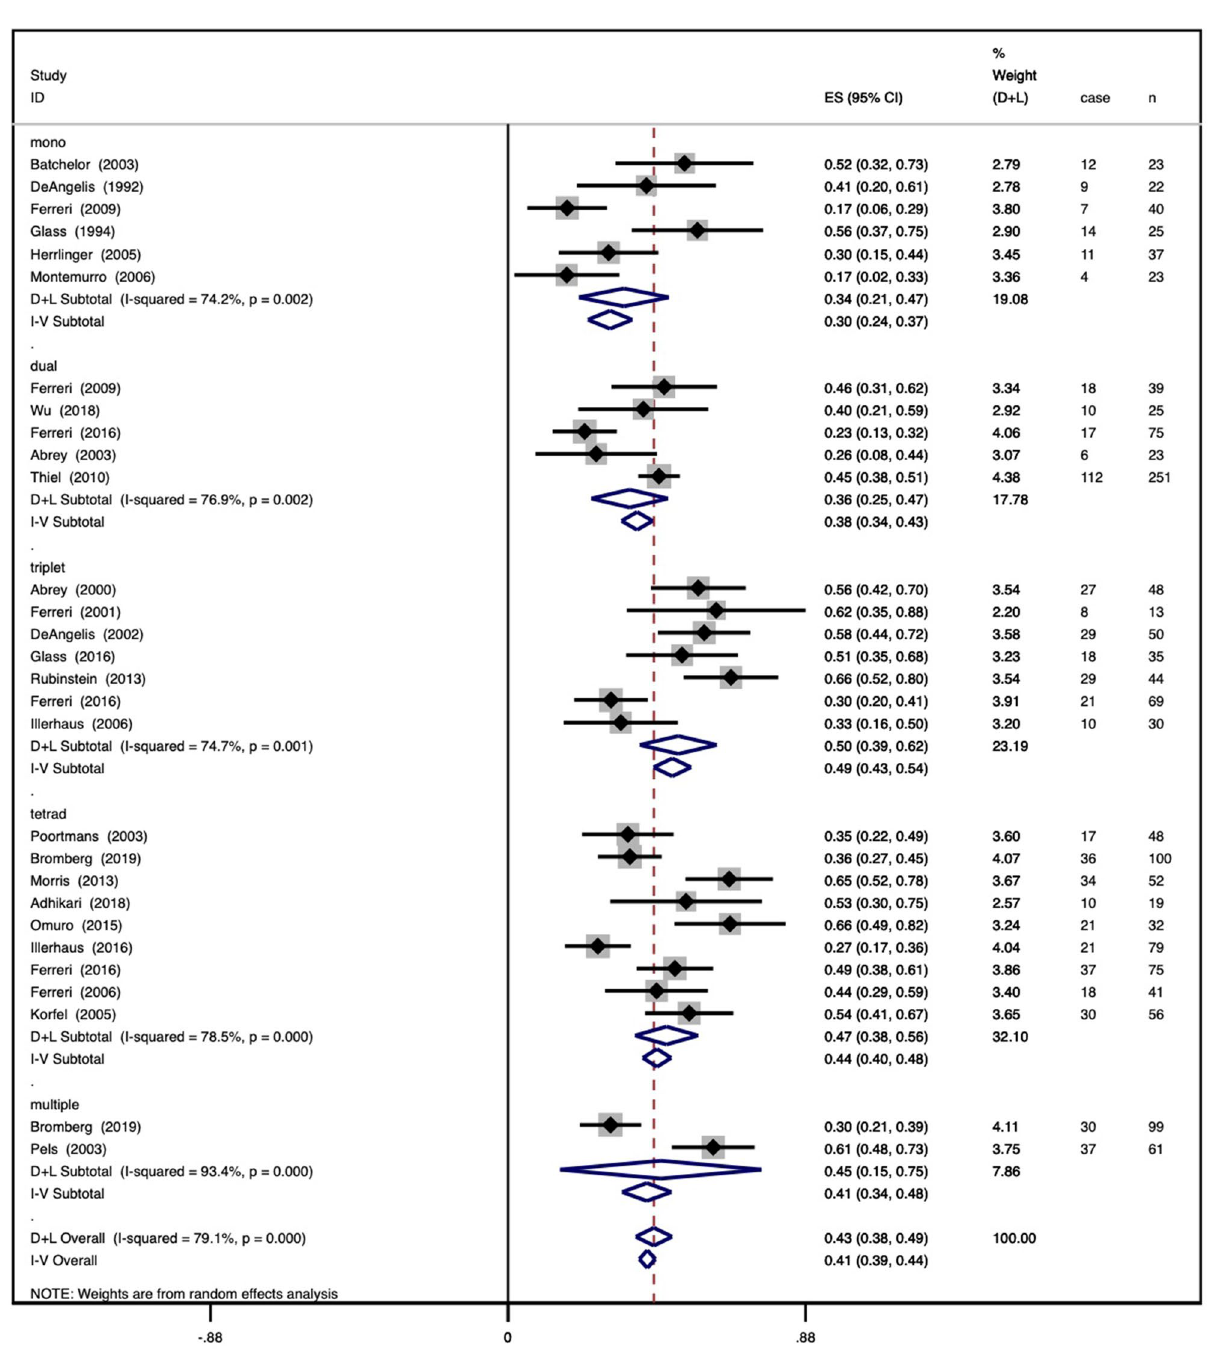
Figure 1. Forest plot of complete remission for regimens. ( a ) Regimens with different numbers of agents and ( b ) regimens with different chemotherapy combinations. A square and bar represents the effect size and 95% CI for each study, respectively, and the size of the square reflects each study’s relative weight. The diamond represents the pooled CRR and 95%